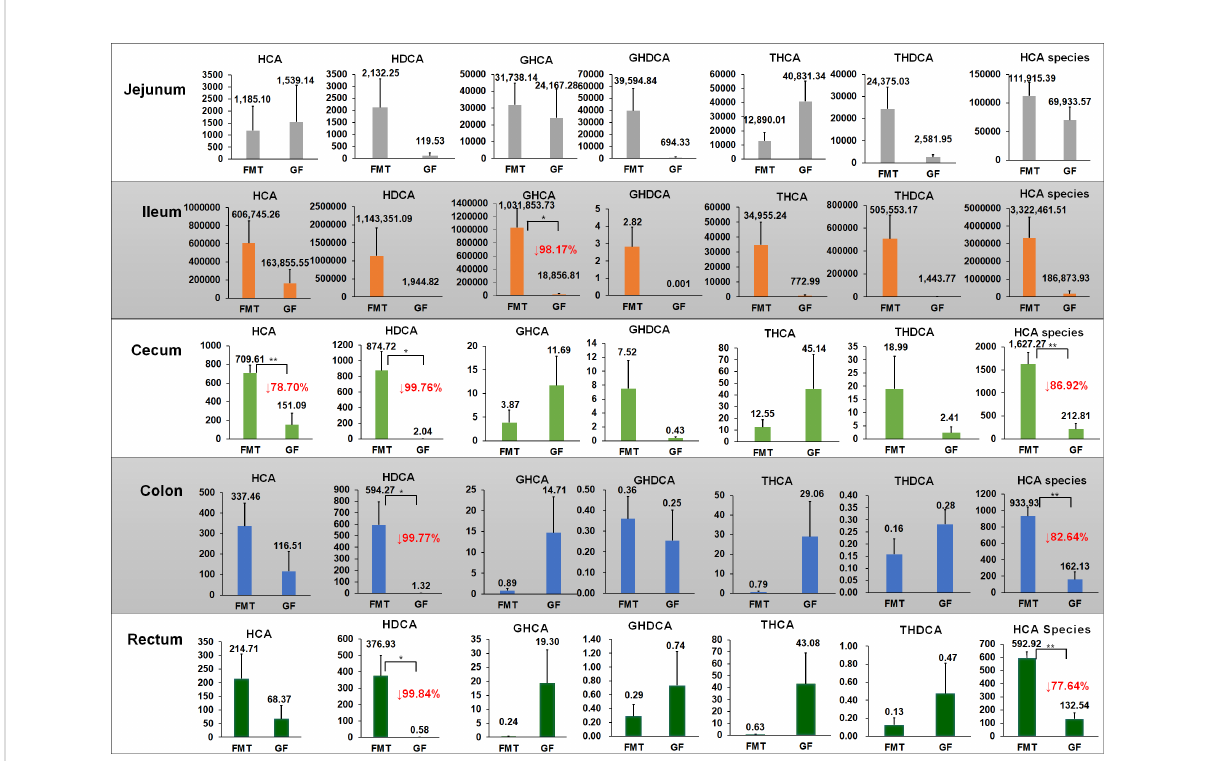
FIGURE 2 Changes in HCA species concentrations in different gut sites after colonization. Concentrations of HCA species in the jejunum, ileum, cecum, colon, and rectum. Mean values ± SE are plotted; n = 5 samples in the GF group, n = 6 samples in the FMT group. Red values with a down arrow represent the percentage reduction (%) of BA in the GF group compared to the FMT group. * P < 0.05, ** P < 0.01 indicate differences versus GF by the Welch Two-Sample t -test. HCA = hyocholic acid; GHDCA = glycohyodeoxycholic acid; GHCA = glycohyocholic acid; THCA = taurohyocholic acid; THDCA = taurohyodeoxycholic acid; HDCA = hyodeoxycholic